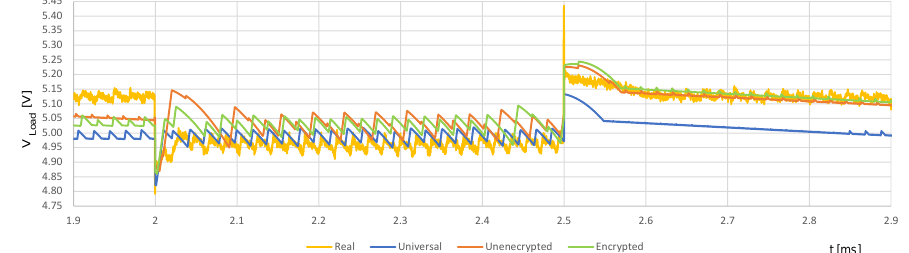
Figure 23. Detailed V Load models and real measurement time graph curves on dynamic load.